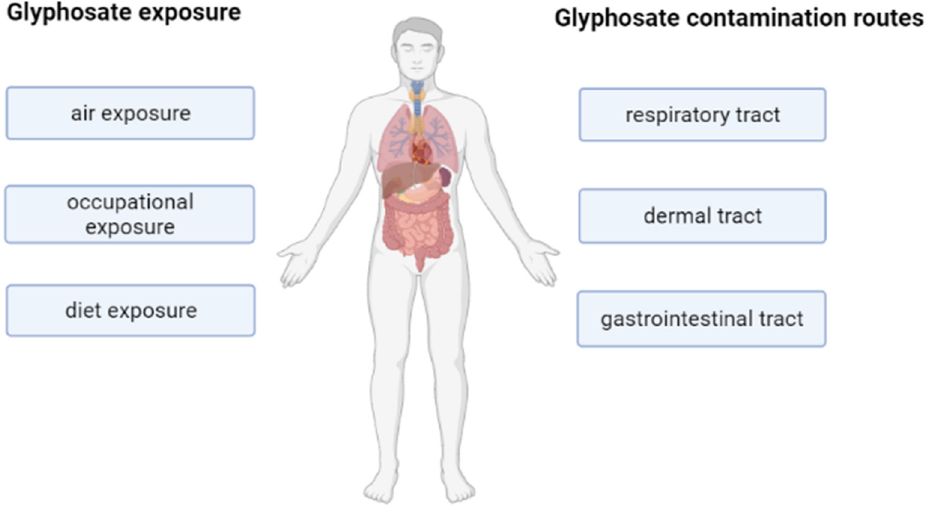
Figure 3. Scheme of the main exposure and contamination routes of glyphosate in humans. Image has been created with BioRender.com, accessed on 1 November